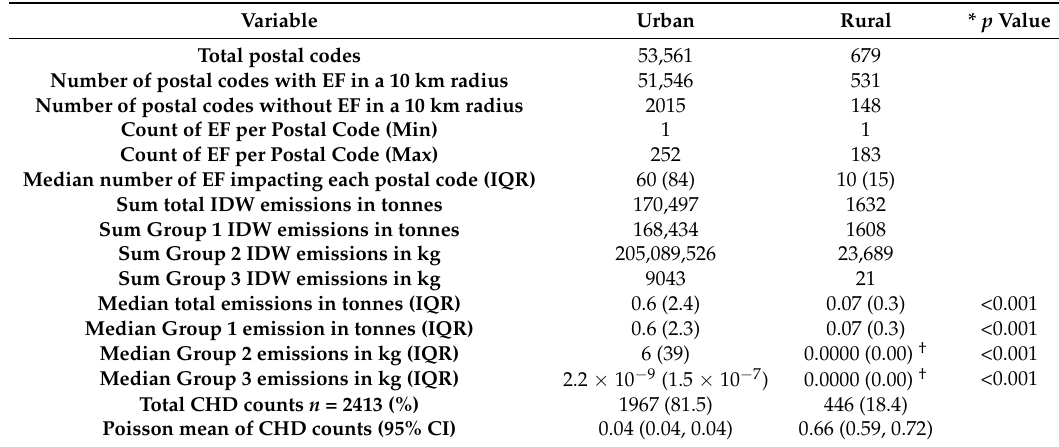
Table 2. Descriptive statistics of the emissions, postal codes exposed to the emissions, and congenital heart defect (CHD) counts in urban and rural Alberta.